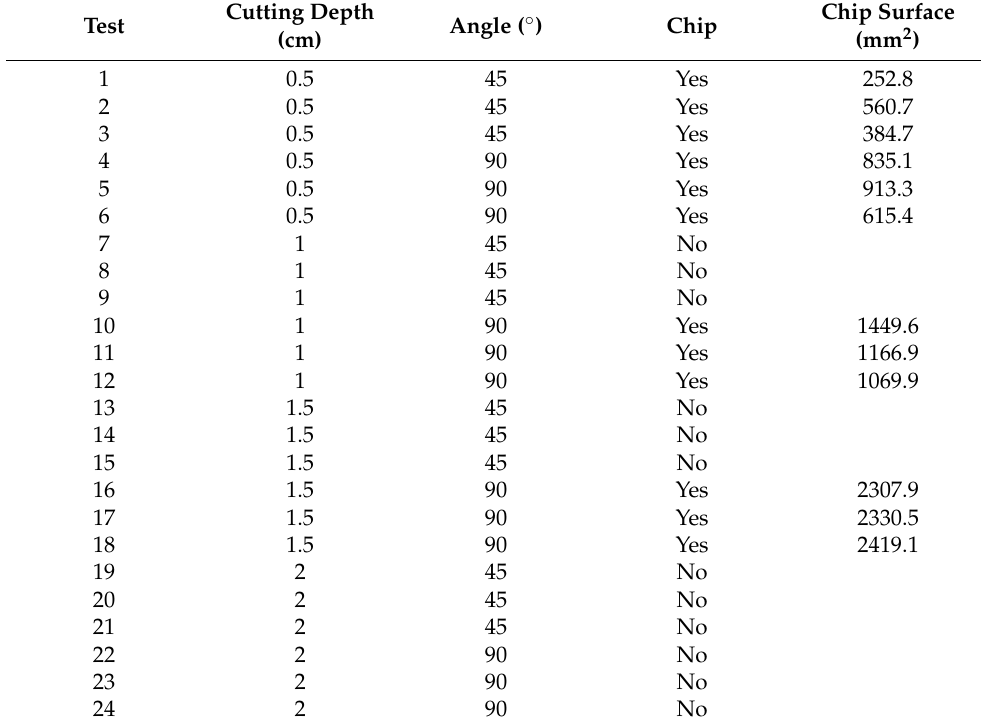
Table 1. Summary of the tests carried out with the initial prototype. (The precision of the measures is of the order of 0.1 cm for the cutting depth, 0.5 ◦ for the angle, and 25 mm 2 for the chip surface). Cutting Depth Angle ( ◦ Test (cm)